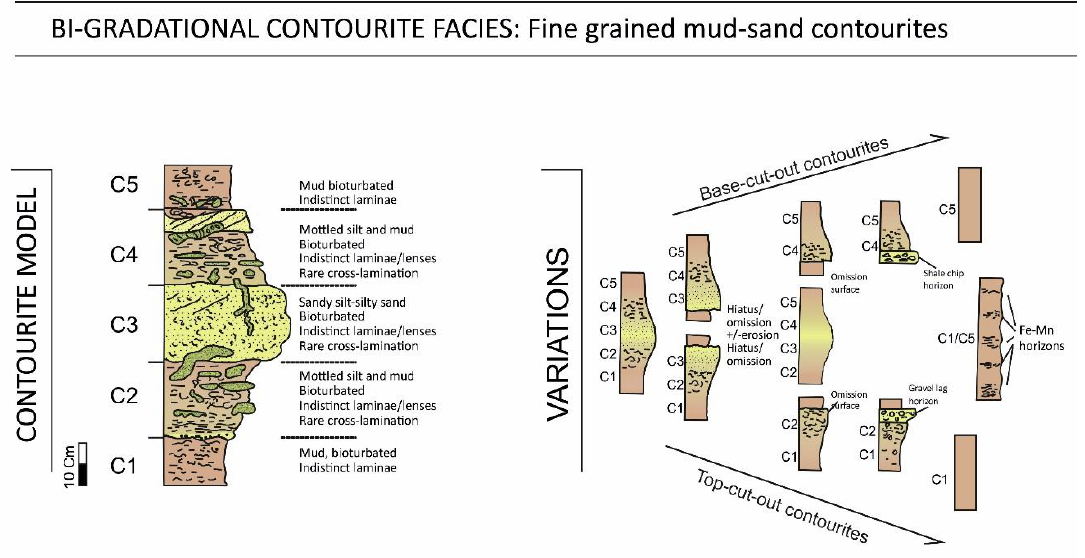
Figure 13. The bi-gradational contourite family for fine-grained mud–sand contourites. The ideal bi-gradational facies model showing the complete sequence of divisions C1–C5 [28,102] and typical partial sequences found commonly in nature is given.